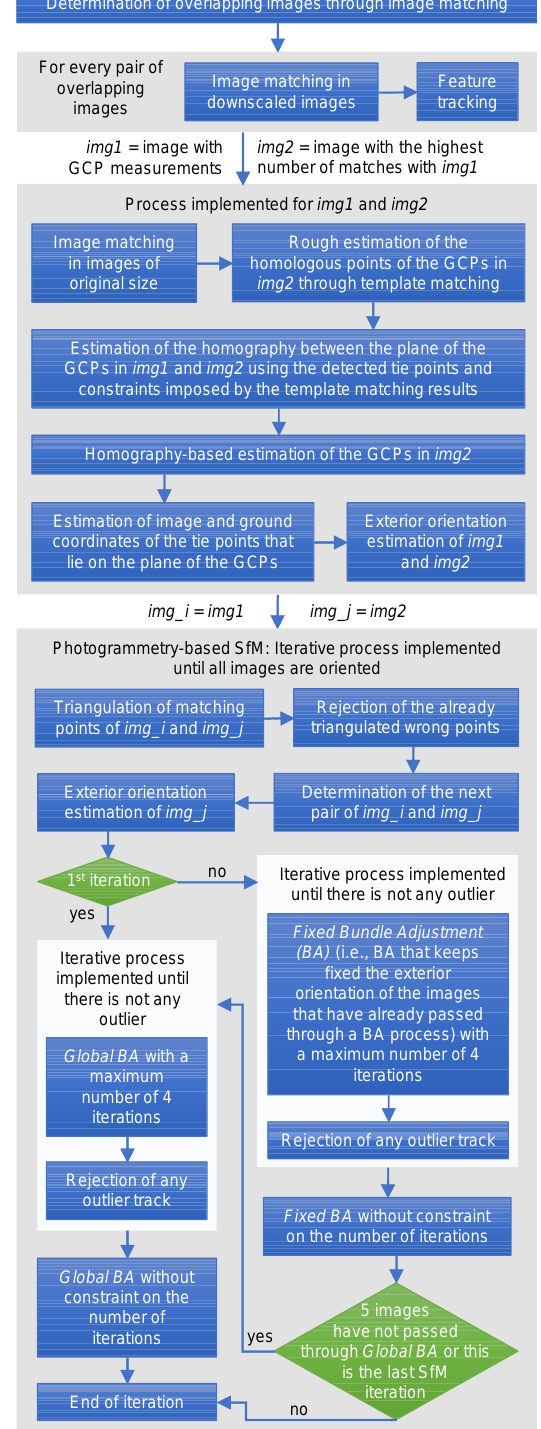
Figure 1. The proposed